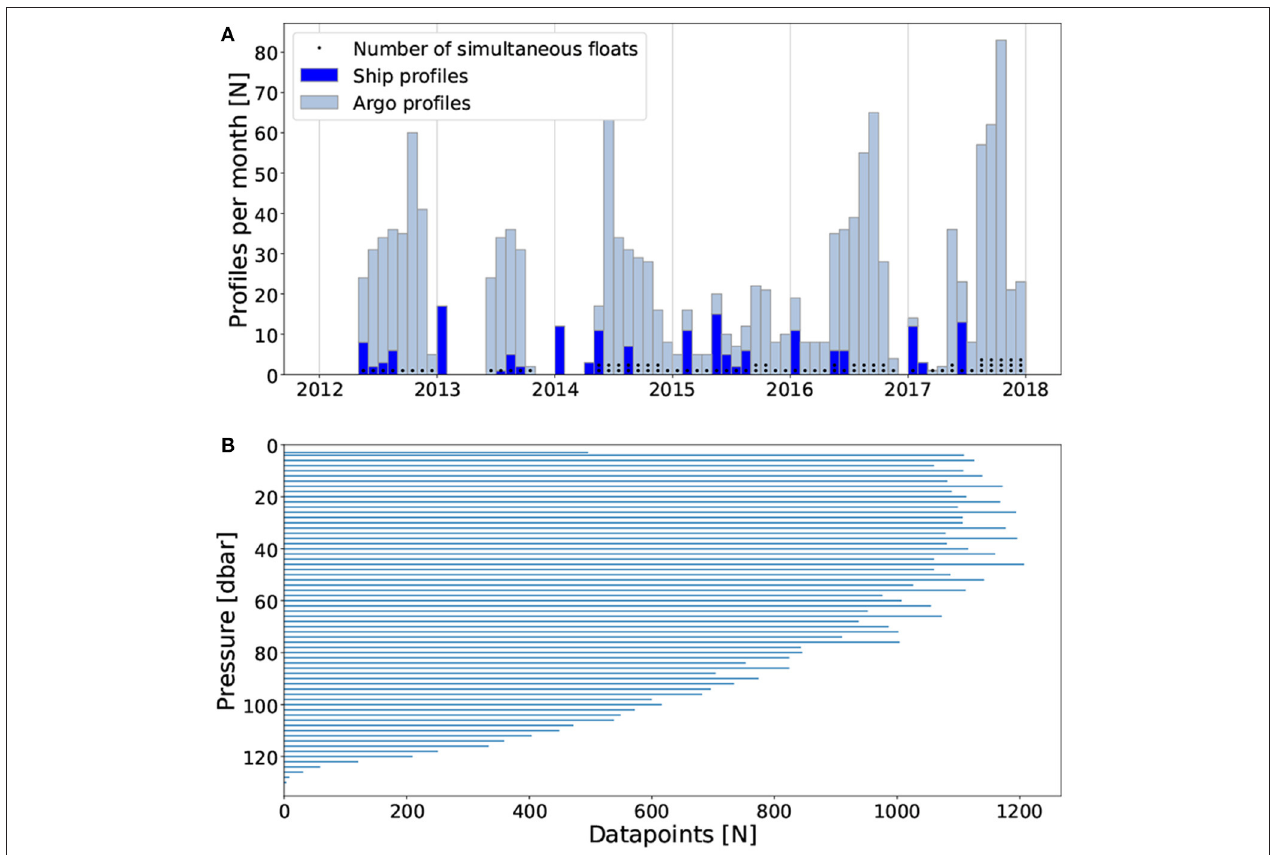
FIGURE 2 | (A) Number of measured Argo profiles (gray) and CTD profiles (blue) per month in the Bothnian Sea for 2012–2017. The black dots represent the amount of simultaneous floats each month. (B) Number of measurements per depth with a 2dbar resolution with the Argo floats during 2012–2017.